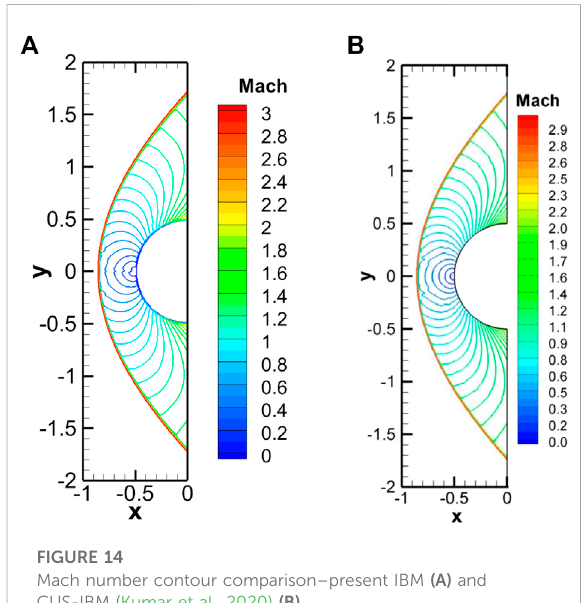
FIGURE 14 Mach number contour comparison – present IBM (A) and CUS-IBM (Kumar et al., 2020) (B) .